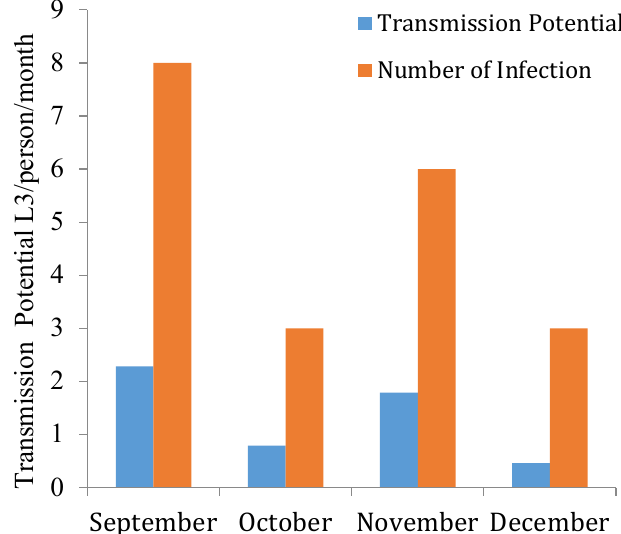
Figure 2. Monthly transmission potential of microfilariae L3 larvae at the Kaduna river banks along Yakowa Express Road. Number of infections: number of flies with L3 stage